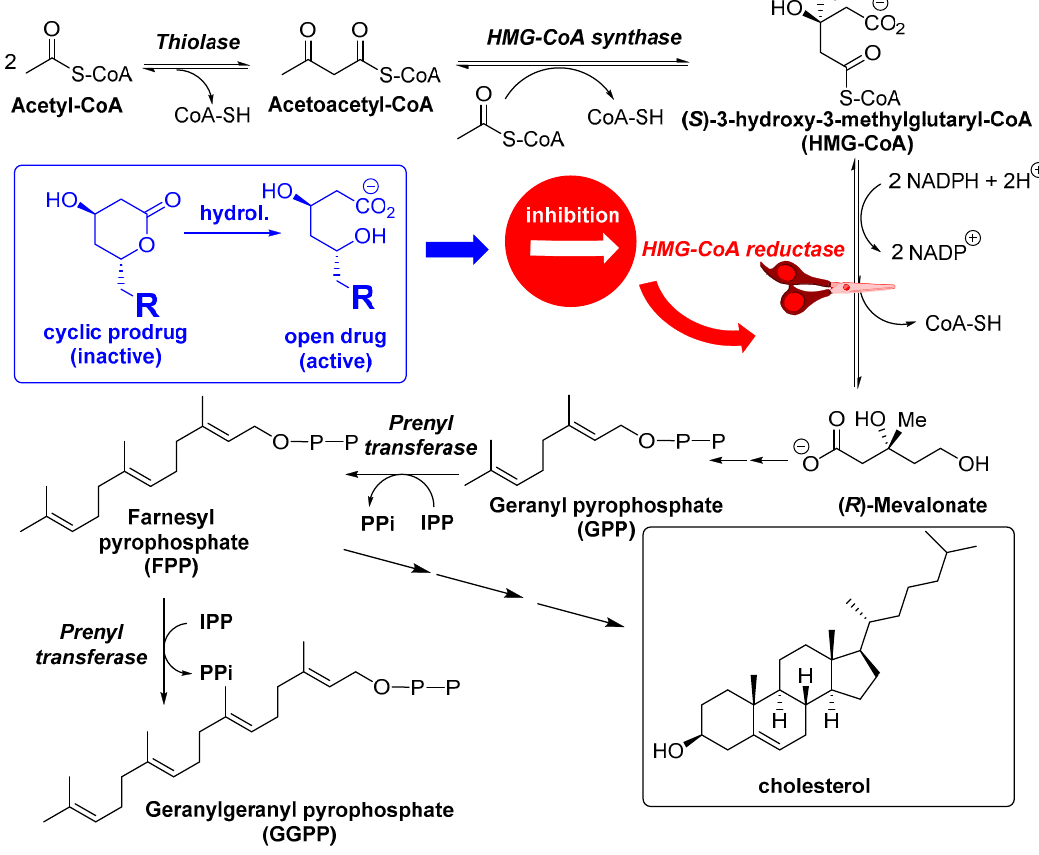
Figure 2. Mevalonate pathway.